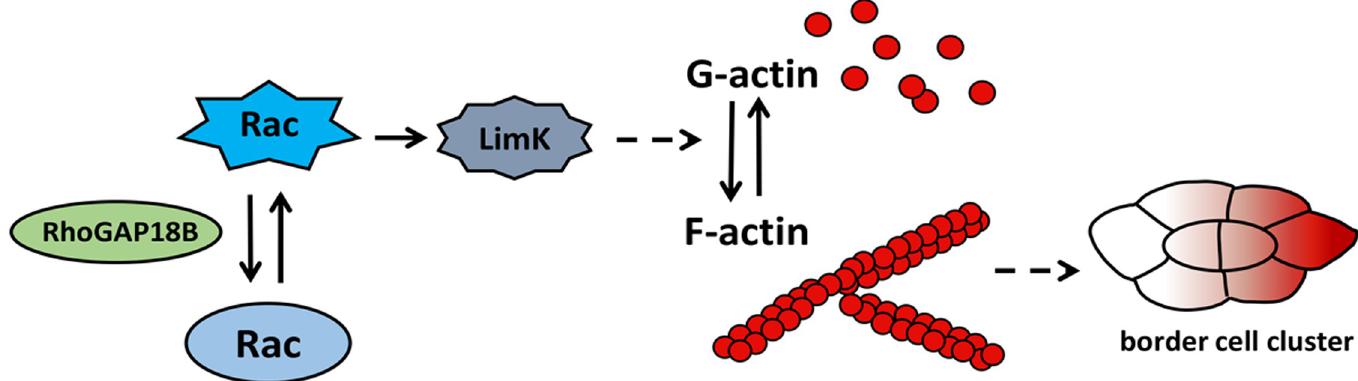
Fig 5. A model showing the roles of RhoGAP18B-PA in regulating collective migration of border cells. Rac function must be precisely controlled in border cell clusters, which is critical for border cells polarize to produce a major F-actin-enriched protrusion. Our data support that RhoGAP18B-PA regulates border cell migration by mediating Rac/LimK